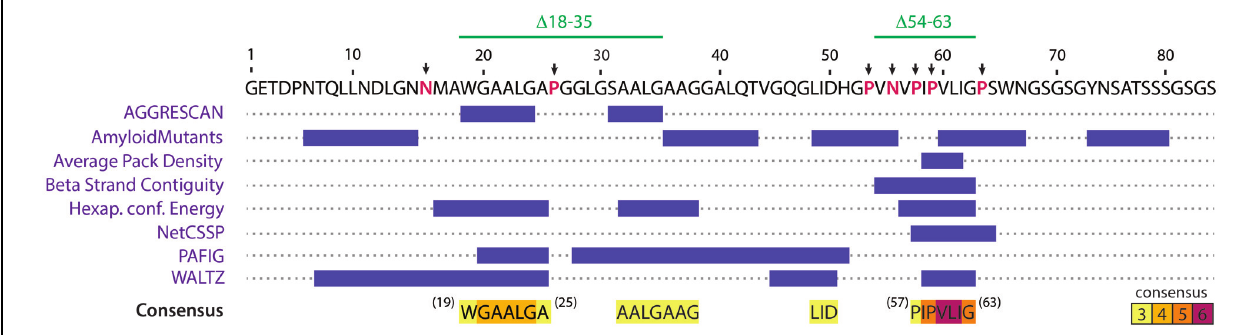
FIGURE 3 | AMYLPRED2 analysis of MccE492 amino acid sequence revealed putative hydrophobic aggregation hotspots. The region encompassing residues 57–63 was recognized as pro-amyloidogenic by six different algorithms (highest consensus score in this sequence). A second region (19–25) was recognized with a lower consensus (only four different algorithms). β -strand disruptors (proline) and polar residues flanking or interrupting predicted hotspots (putative aggregation gatekeepers) are shown in red and pointed with black arrows. With this information, a collection of mutants was generated, in which putative gatekeeper residues were individually substituted by alanine, and the two regions comprising putative aggregation hotspots (18–35 and 54–63) were